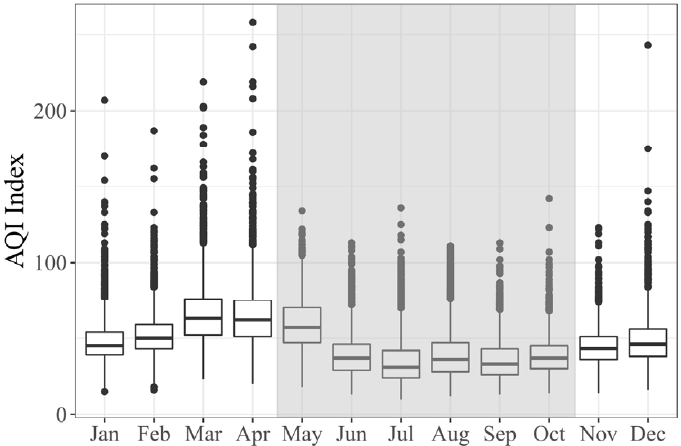
Figure 5. Characteristics of monthly AQI changes from 2015–2020, with shaded areas indicating the wet season (May–October).